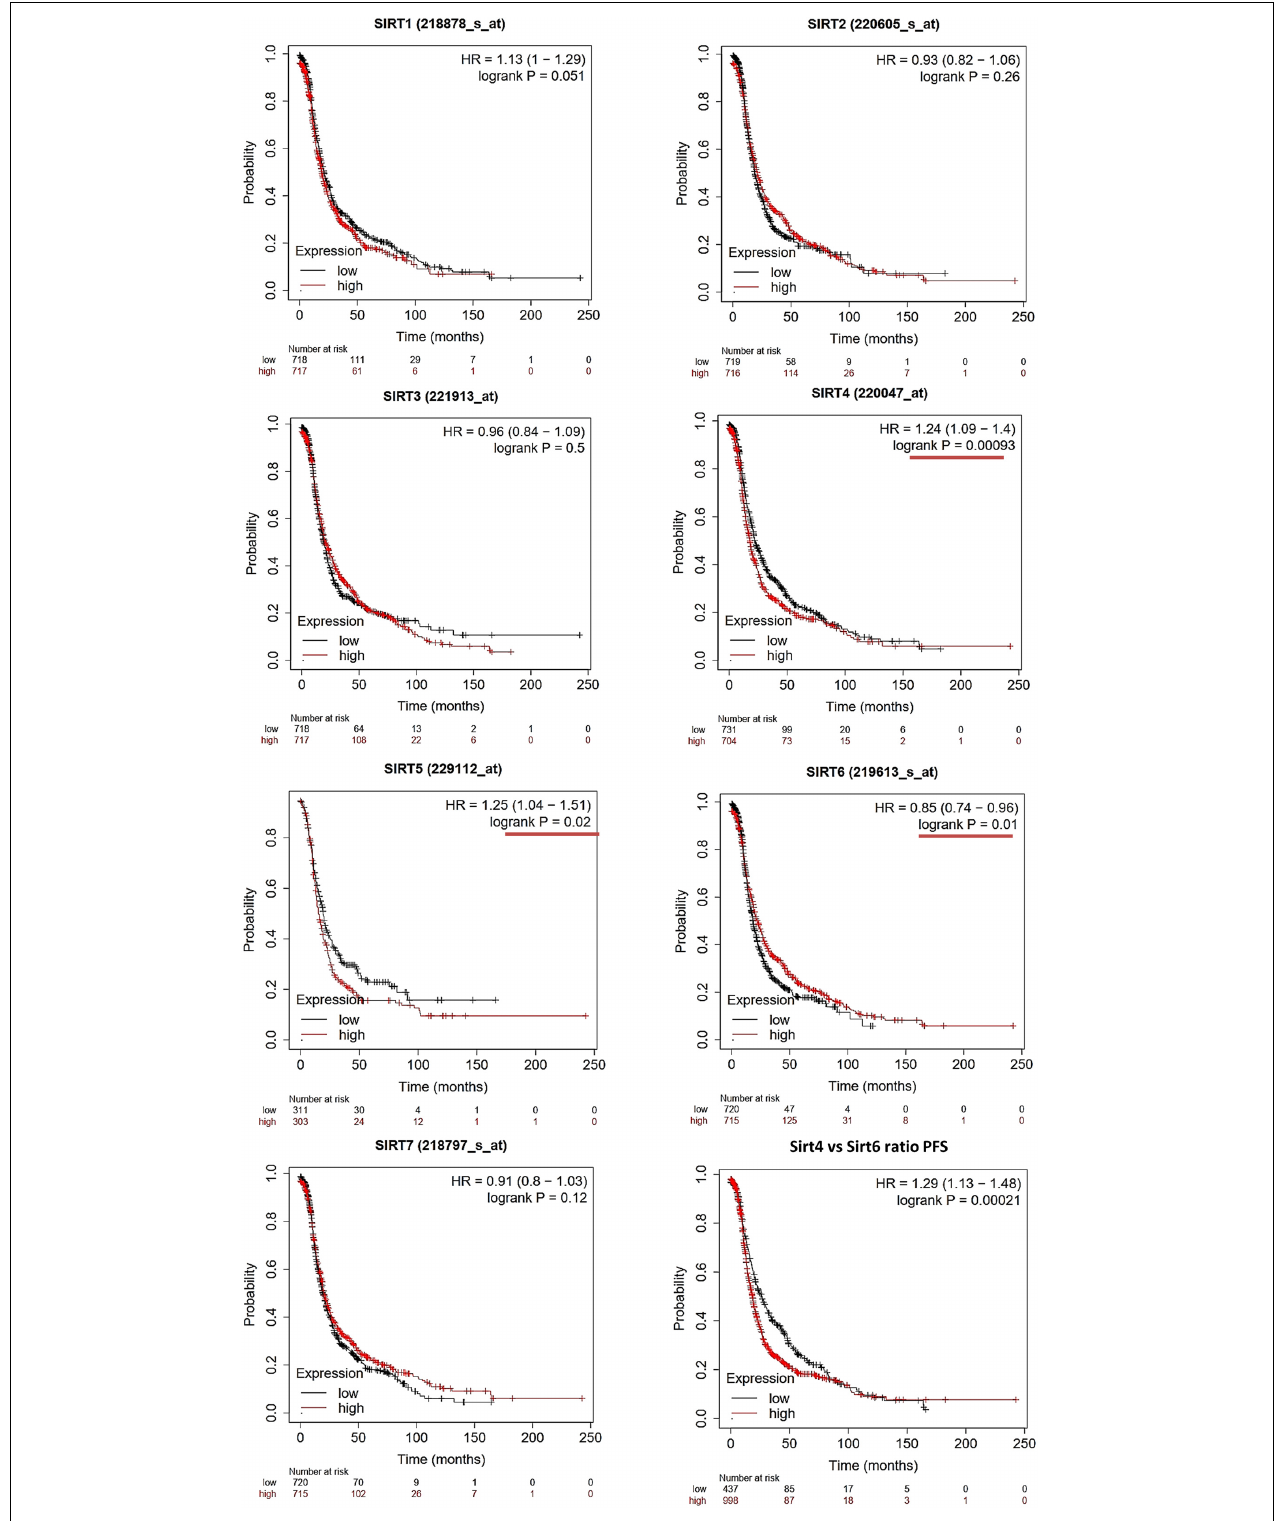
FIGURE 2 | Prognostic values of the sirtuin family members with probe IDs in ovarian cancer patients, as obtained using the Kaplan–Meier (KM) Plotter ( n = 1,425) for progression-free survival (PFS) analysis. A log-rank p < 0.05 was considered statistically significant and is marked with a red underline . The median expression level was set as the cutoff for the KM plot. The red line indicates high expression and the blue line indicates low expression.